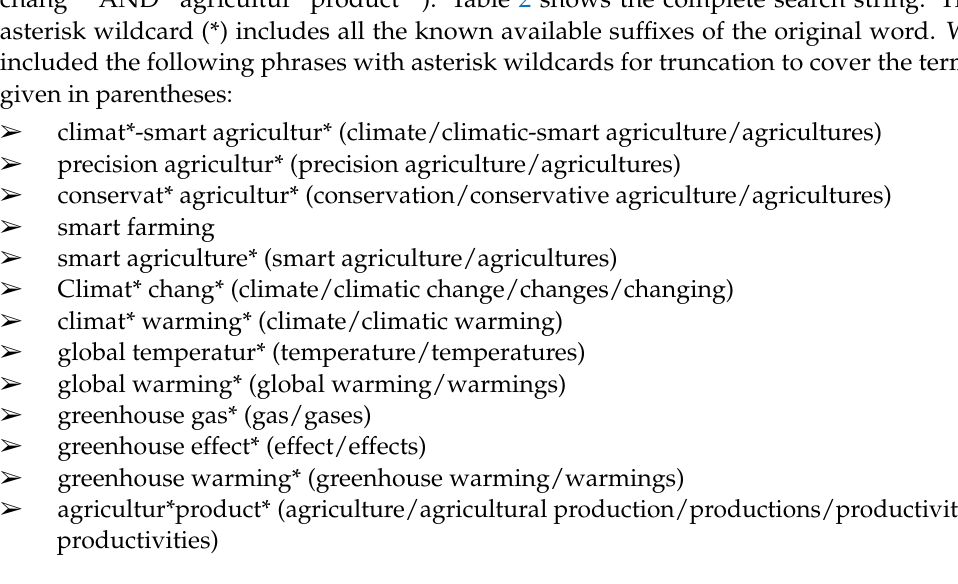
Table 1. Criteria, eligibility, and elimination strategies.